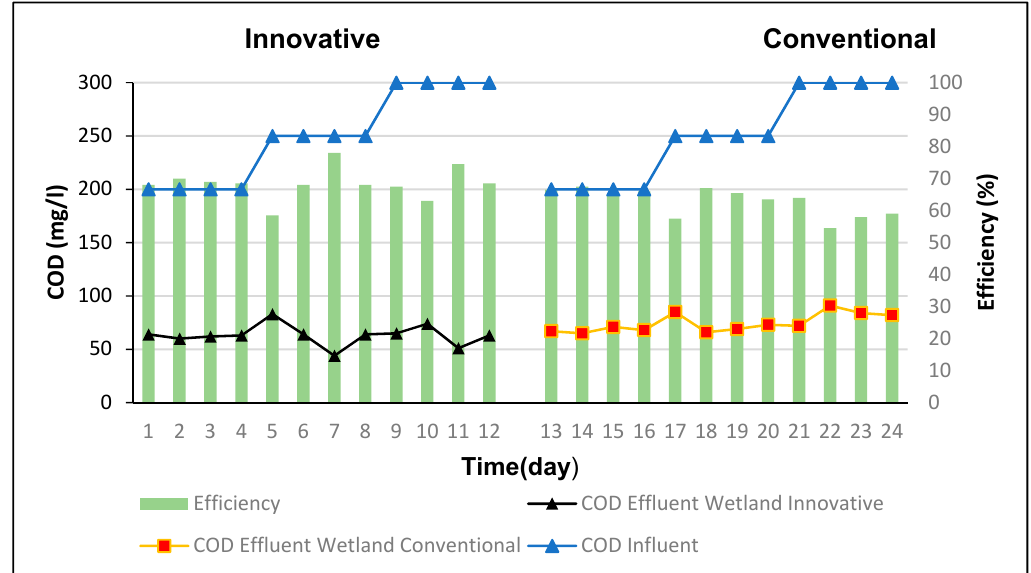
Figure 8. COD concentrations of influent and e ffl uent in the pilot-scale wetland.